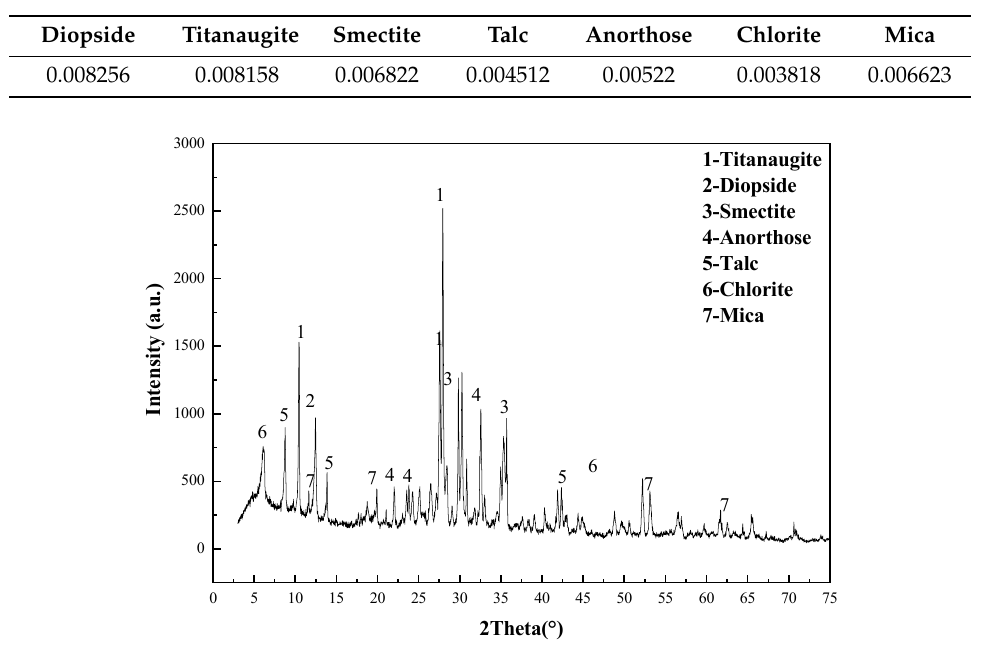
Table 2. Main Sc-bearing minerals in the scandium rough concentrate (wt %).